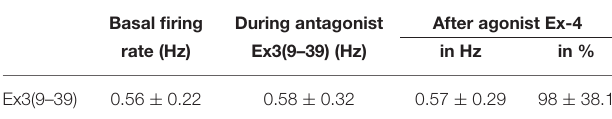
TABLE 2 | Changes in firing rate in GnRH neurons upon Exendin-4 administration with antagonist (Exendin3(9–39)) pretreatment. Basal firing During